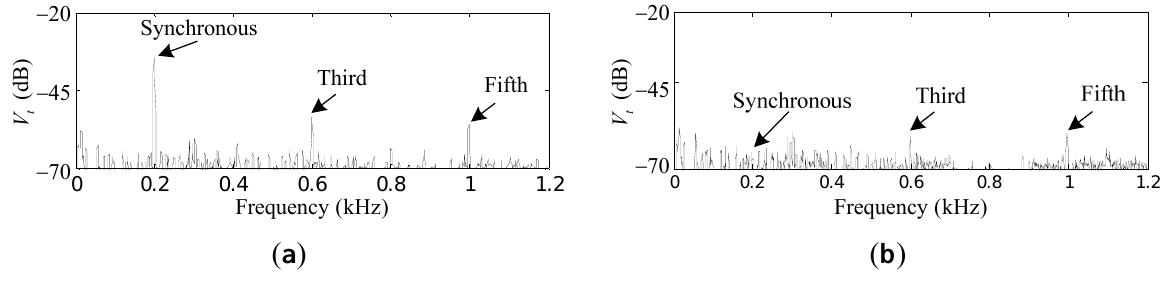
Figure 21. Experiment results of V t : ( a ) before field balancing and harmonic vibration suppression; ( b ) after field balancing and harmonic vibration